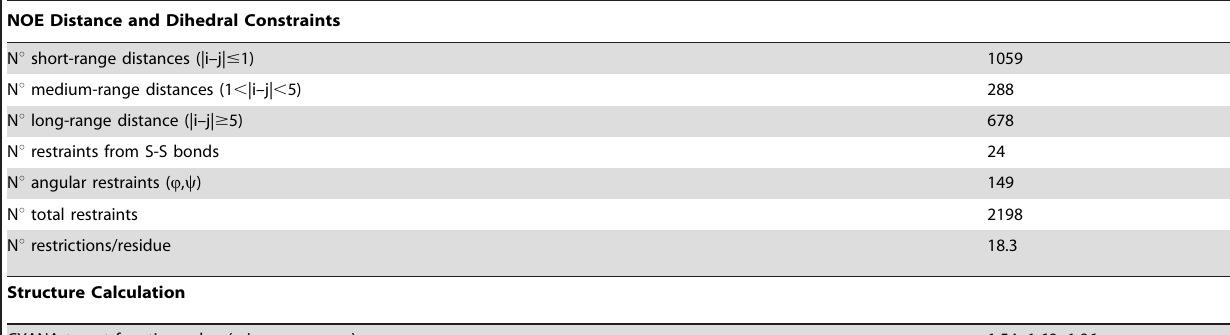
Table 2. Structural Statistics of the 20 best NMR Structures of the